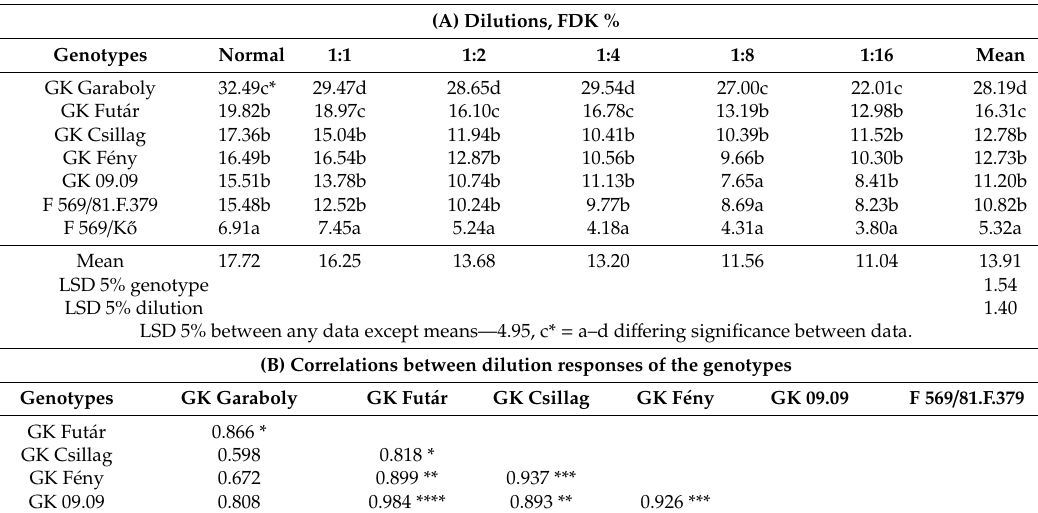
Table 6. Reduction of the aggressiveness of the winter wheat genotypes at di ff erent dilutions across isolates and experiments, FDK data as a percentage in 2013–2014. ( A ) Dilutions, FDK %. ( B ) Correlations between dilution responses of the